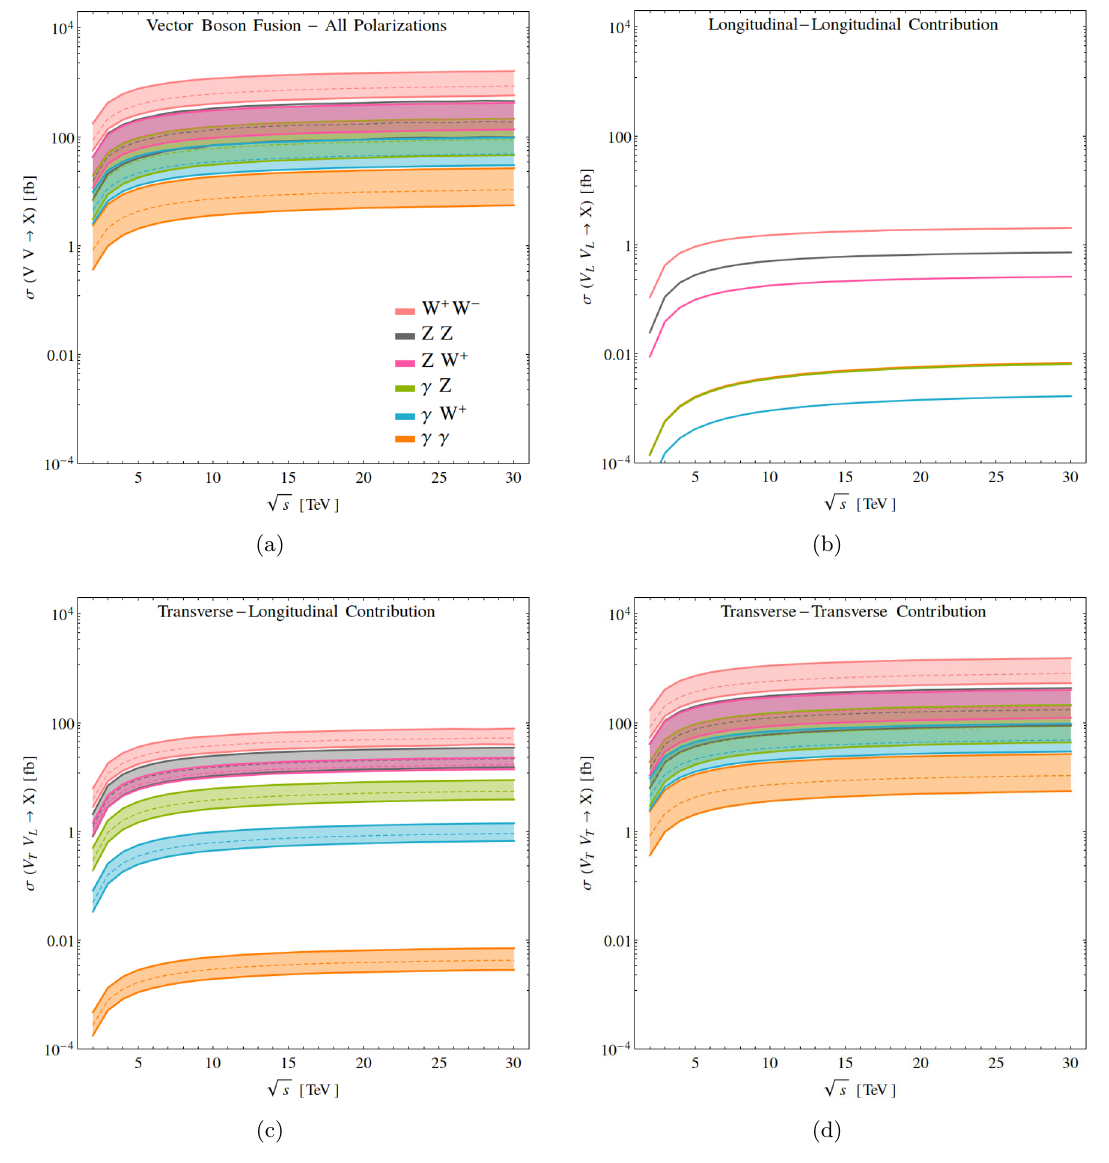
Figure 9 . Same as figure 7 but for V V